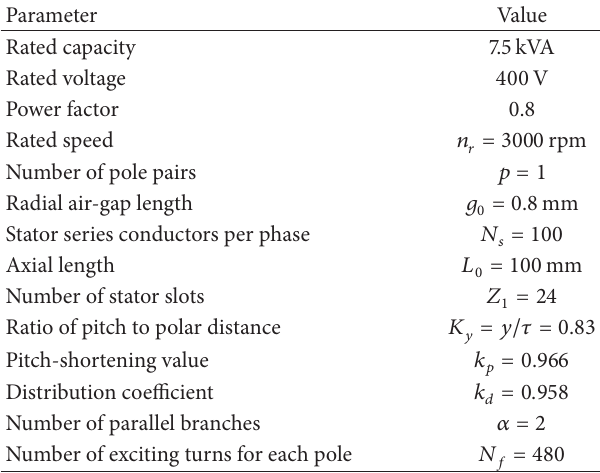
Table 2: Primary parameters of SDF-9 type